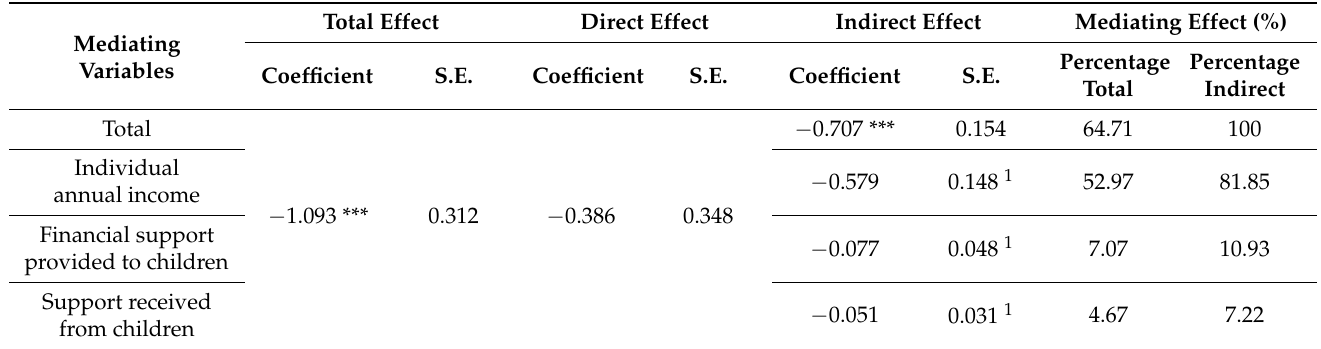
Table 8. Components of Indirect Effects using the